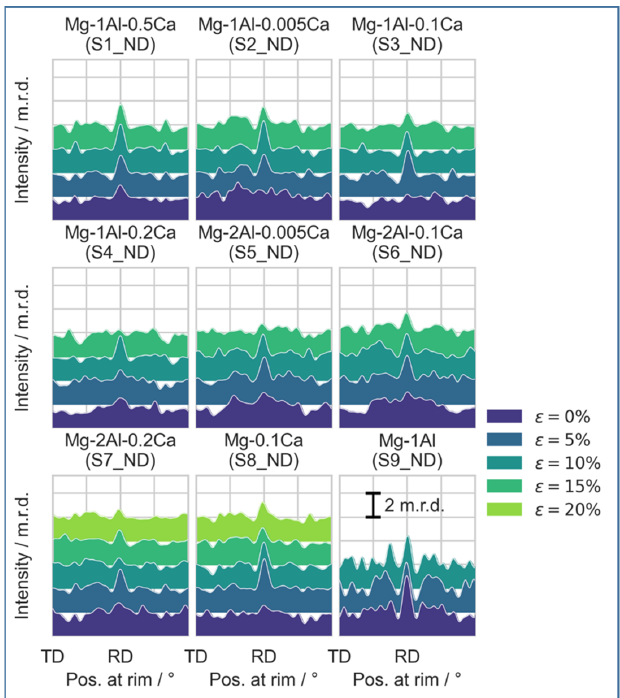
Figure 6. Preferred components for S_ND samples as variation along the rim of the {1010}-pole figures. Distance between TD and RD is 90°.